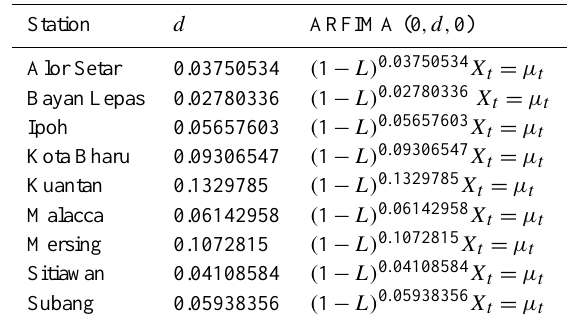
Table 3. Differencing parameter estimates with ARFIMA (0 ,d, 0) model. Station d